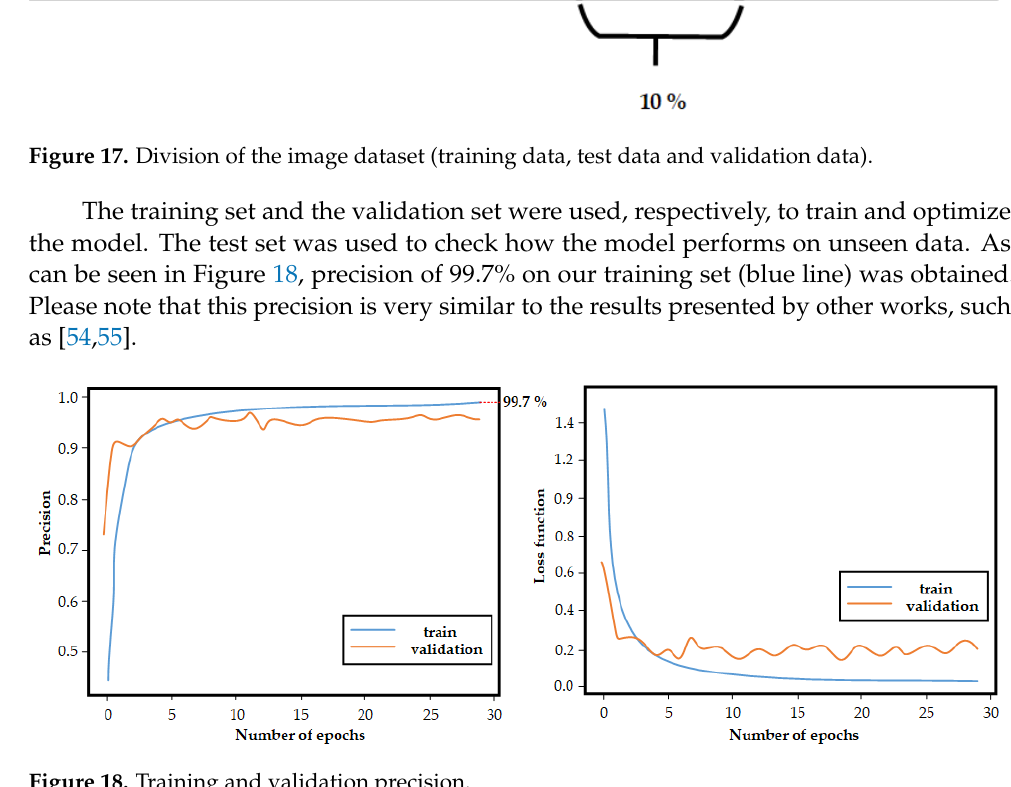
Figure 18. Training and validation